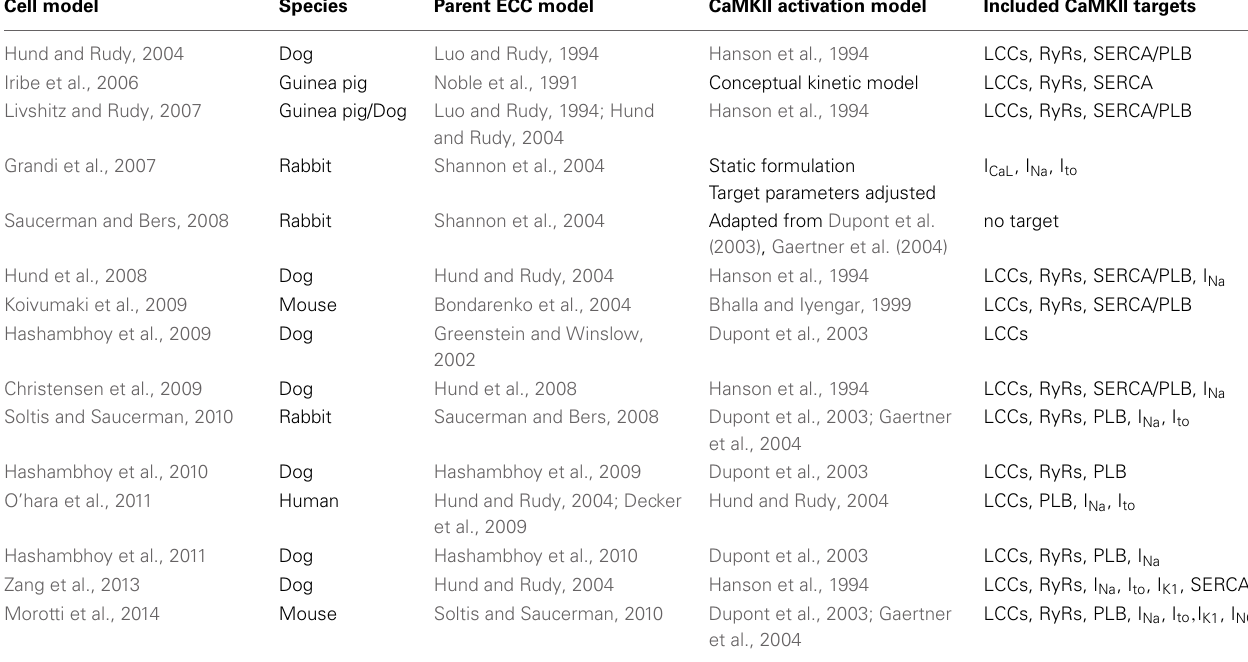
Table 1 | Key features of CaMKII models in cardiac